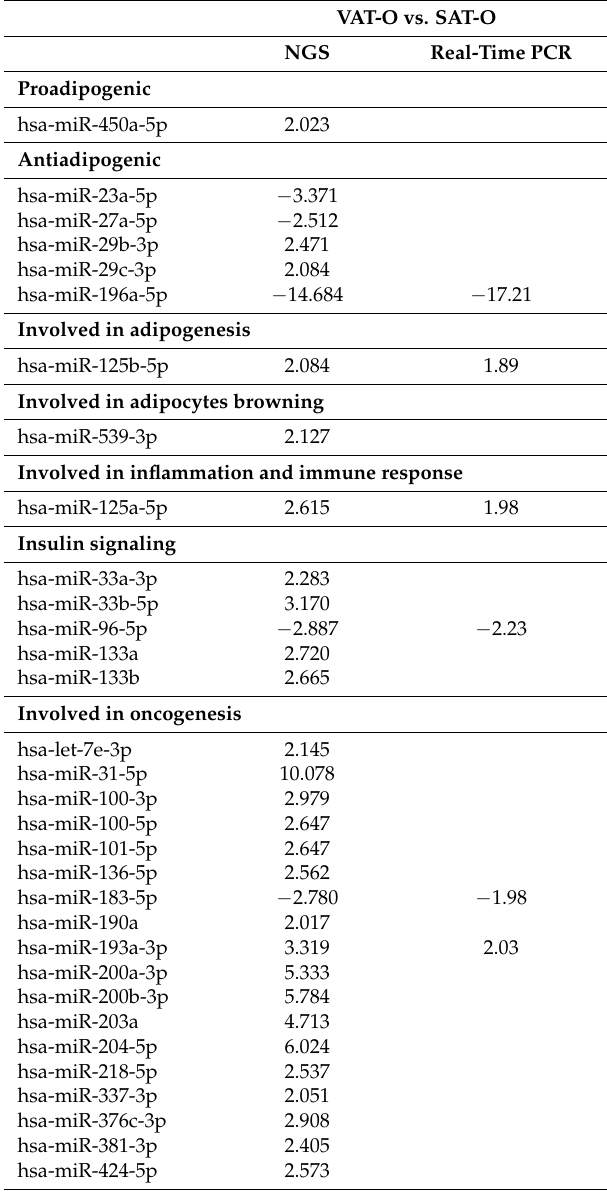
Table 2. Fold changes of miRNA differentially expressed in visceral (VAT) and subcutaneous adipose tissue (SAT) of obese (O) individuals assessed by the next generation sequencing (NGS) and the real-time PCR